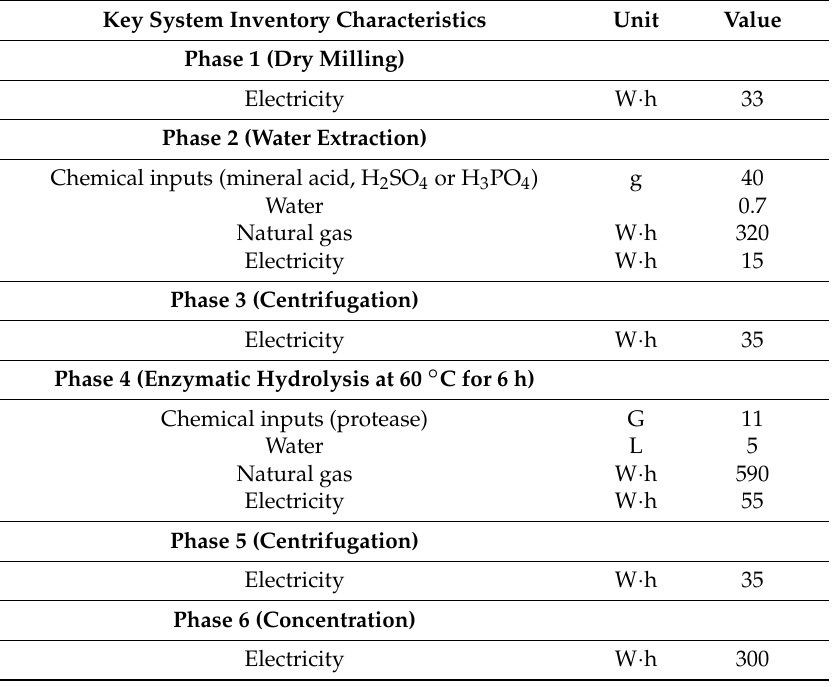
Table 3. Key characteristics of the production process of protein hydrolysate-based biostimulant from lupine seeds (data refer to the production of 1 kg of protein hydrolysate). Key System Inventory